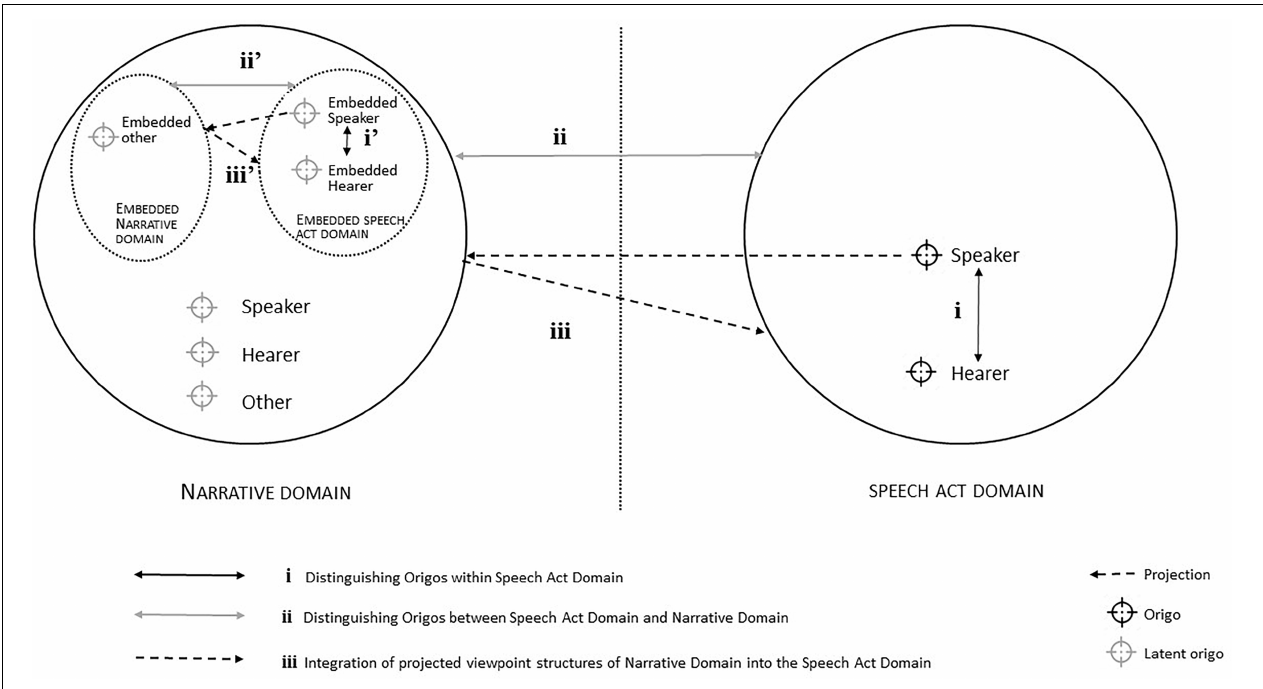
FIGURE 2 | Deictic Navigation Network with three Navigation Routes: (i) the navigation of origos in the Speech Act Domain; (ii) the navigation of actual origos in the Speech Act Domain versus the navigation of projected origos in the Narrative Domain; and (iii) the integration of projected viewpoints structures in the Narrative Domain into the Speech Act